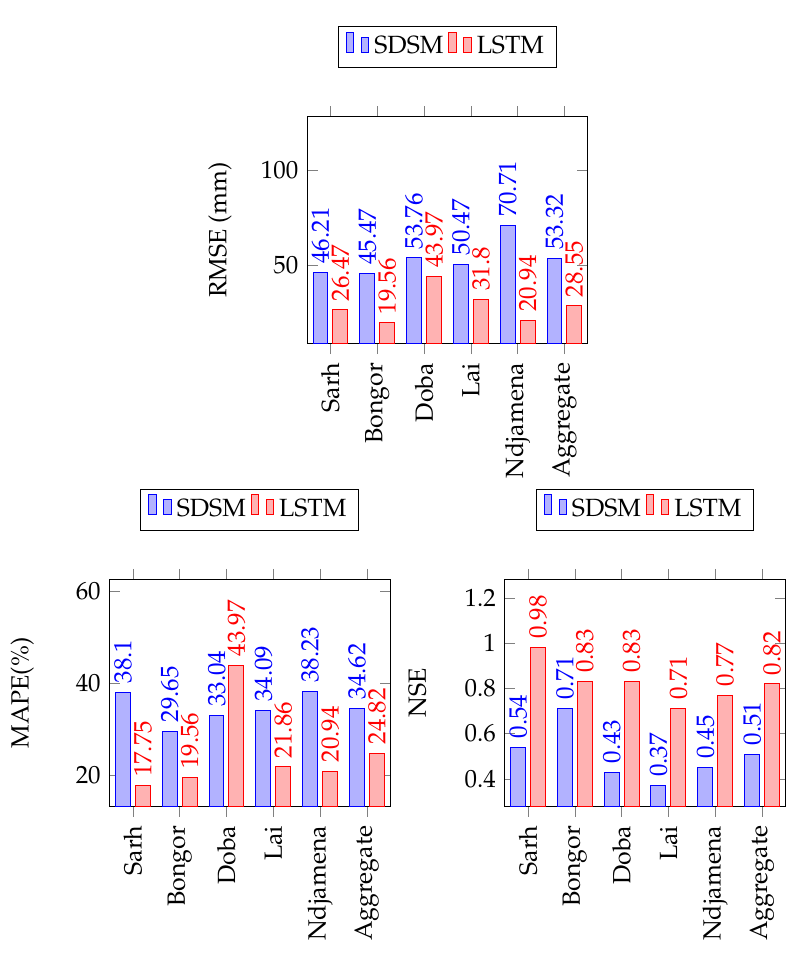
Figure 15. Comparison of SDSM & LSTM for monthly precipitations forecast in the Lake Chad Basin. A comparison of SDSM and LSTM for minimum and maximum temperatures